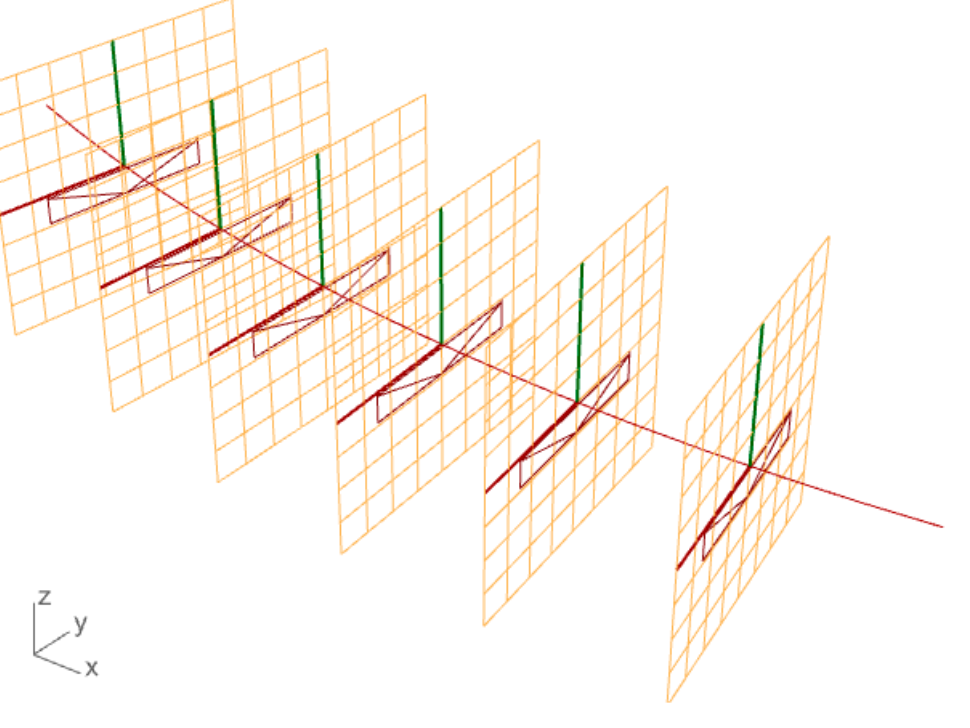
Figure 3. Cross-sections alignment and rotation according to the bridge axis (Equation (1)).